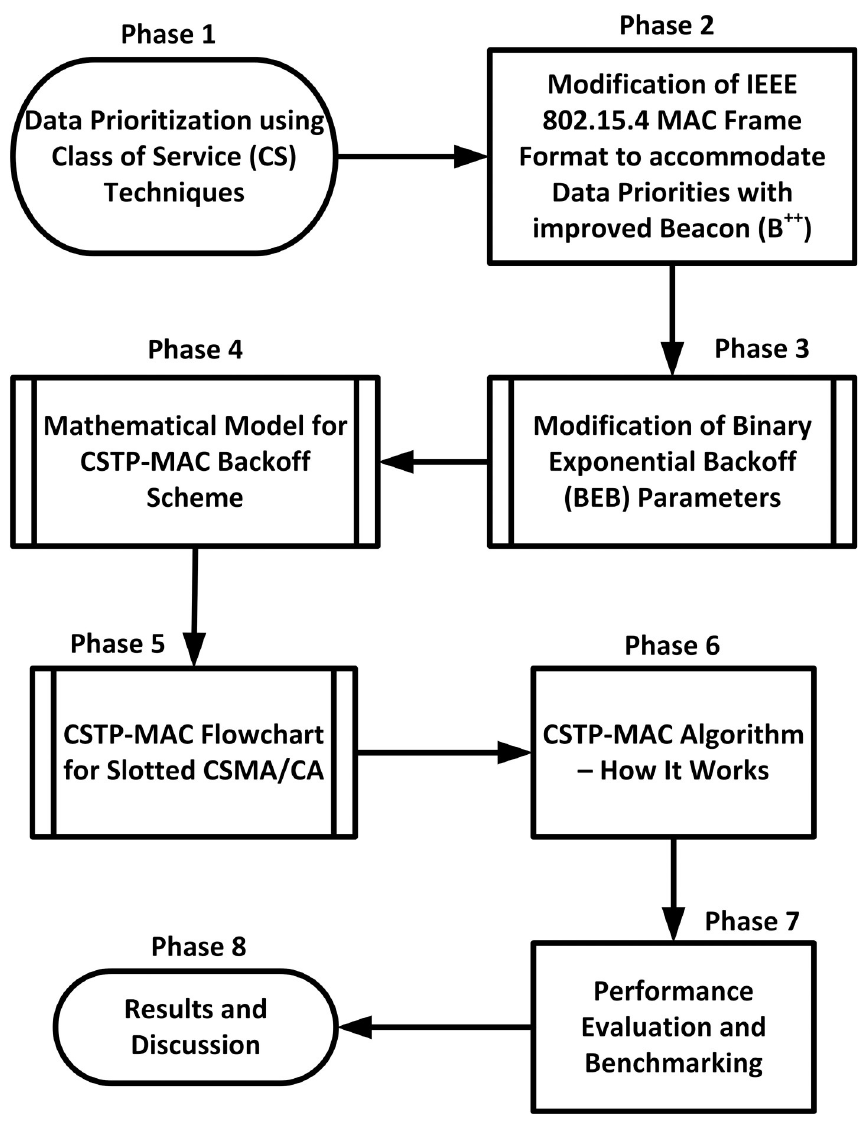
Fig 2. CSTP-MAC methodological